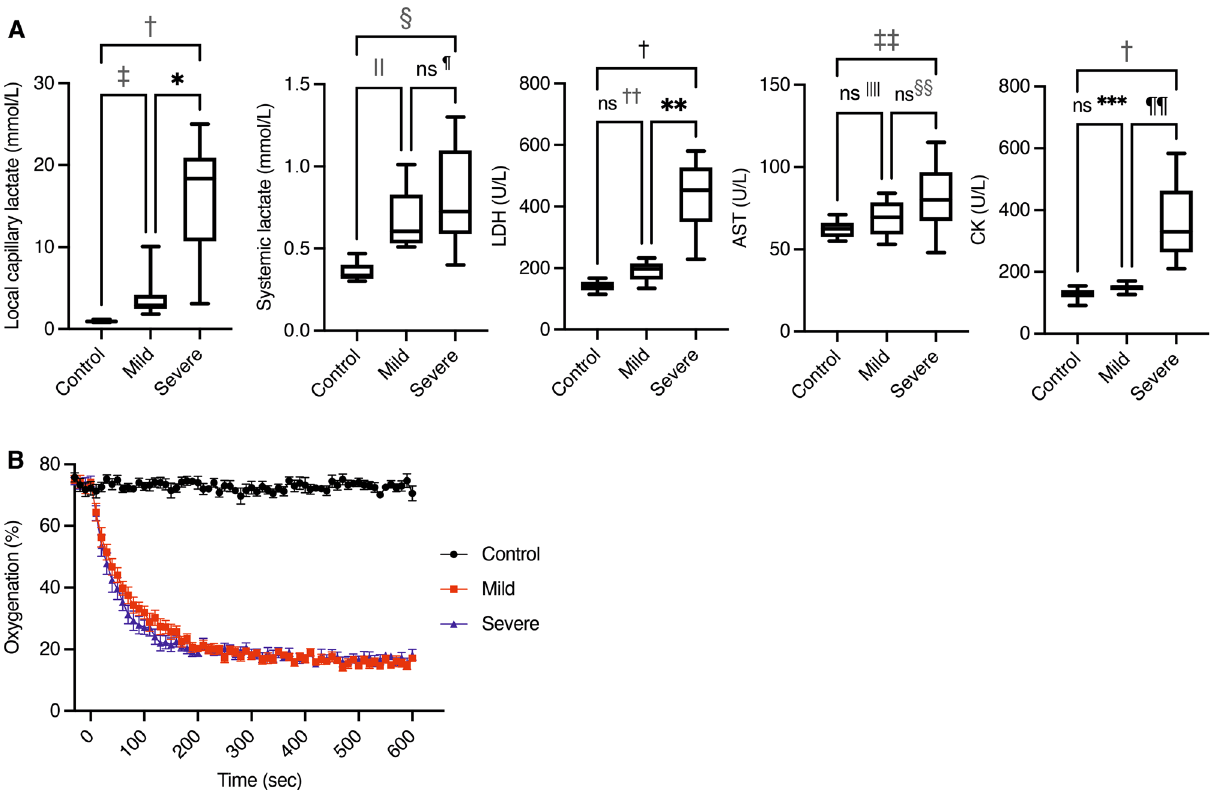
Figure 1. ( A ) Results of laboratory tests in the three groups (n = 10 rats per group). Note: Values are expressed as box and whiskers plots; the minimum and the maximum value (whiskers), and the 25th and 75th percentile (box), and median. Control, control group; Mild, mild acute mesenteric ischemia group; Severe, severe acute mesenteric ischemia group; LDH, lactate dehydrogenase; AST, aspartate transaminase; CK, creatine phosphokinase; ns, not significant; ✻ P = .0283; ✝ P < .0001; ǂ P = .0437; § P = .0001; ❘❘ P = .0023; ¶ P > .9999; ✻✻ P = .0204; ✝✝ P = .1083; ǂǂ P = .0237; §§ P = .4318; ❘❘❘❘ P = .6969; ¶¶ P = .0104; ✻✻✻ P = .2260. The Kruskal–Wallis test was used for evaluation. ( B ) Time course of mean oxygenation of the control, mild, and severe groups in the early stage of AMI. The mean oxygenation of the three groups from 30 s before clamping to 10 min after clamping. A rapid decrease of oxygenation from baseline (> 70%) after clamping is clearly visualized. The oxygenation reaches a plateau within 5 min. Oxygenation of the mild and severe group does not show a significant difference at baseline (0 min), 1, 5, and 10 min after clamping. Note: Error bars represent standard errors of the mean (n = 10 rats per